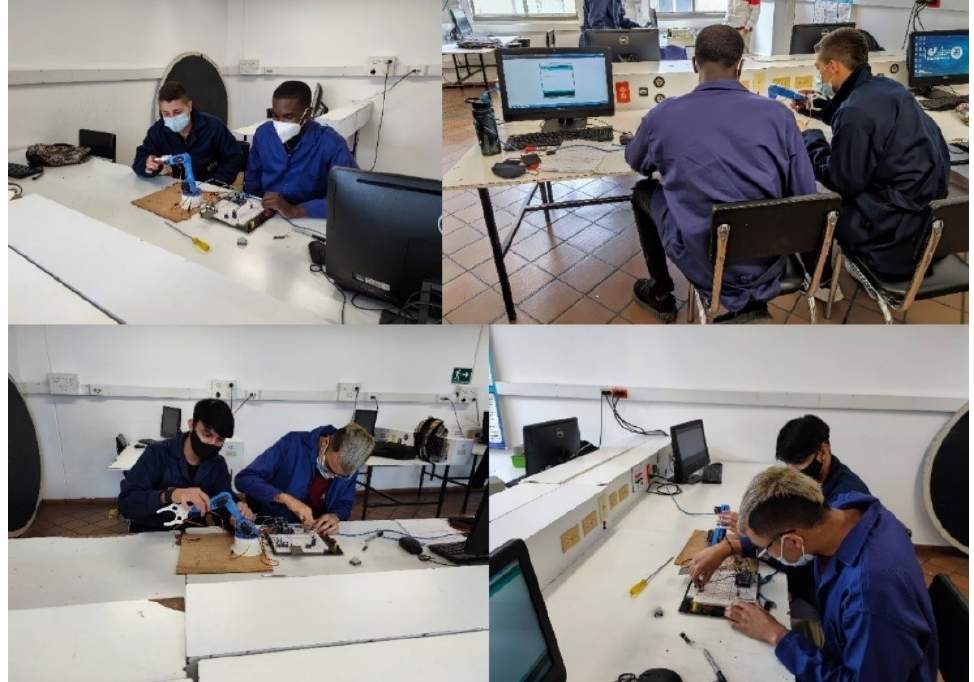
Figure 7. Photographic evidence of the random groups that developed the case study using IRArduino-SPL for the software development of an industrial robotics system with